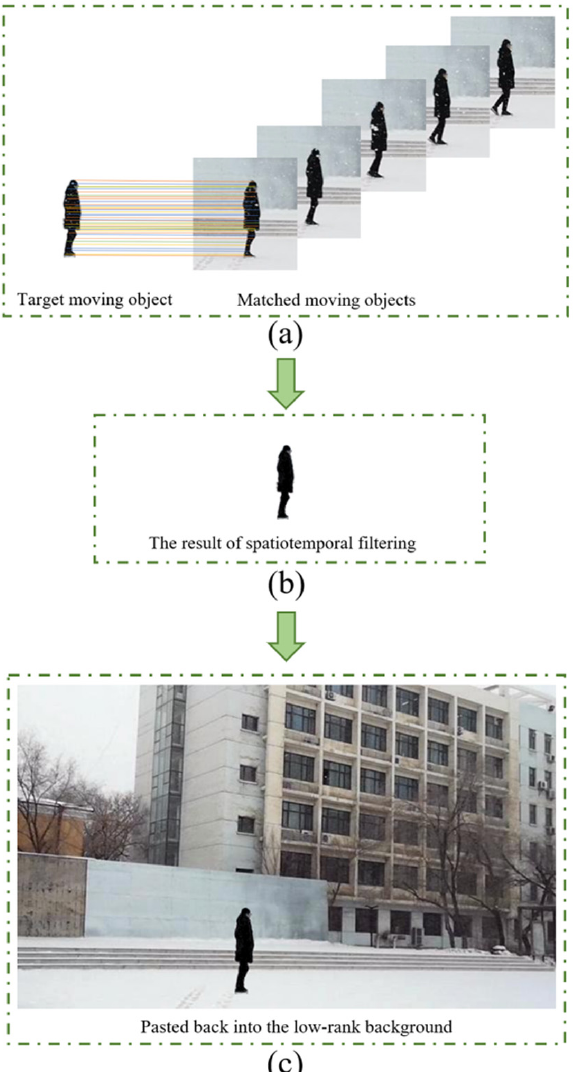
Figure 3. ( a ) The moving object matching processes, ( b ) the result of dual adaptive spatiotemporal filtering, ( c ) the clean video frame obtained by pasting the desnowing moving object back into a low-rank background.